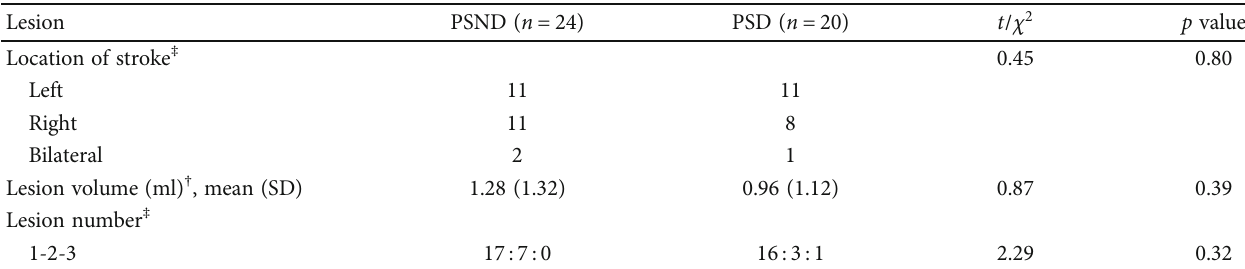
Table 2: Lesion information of all patients.